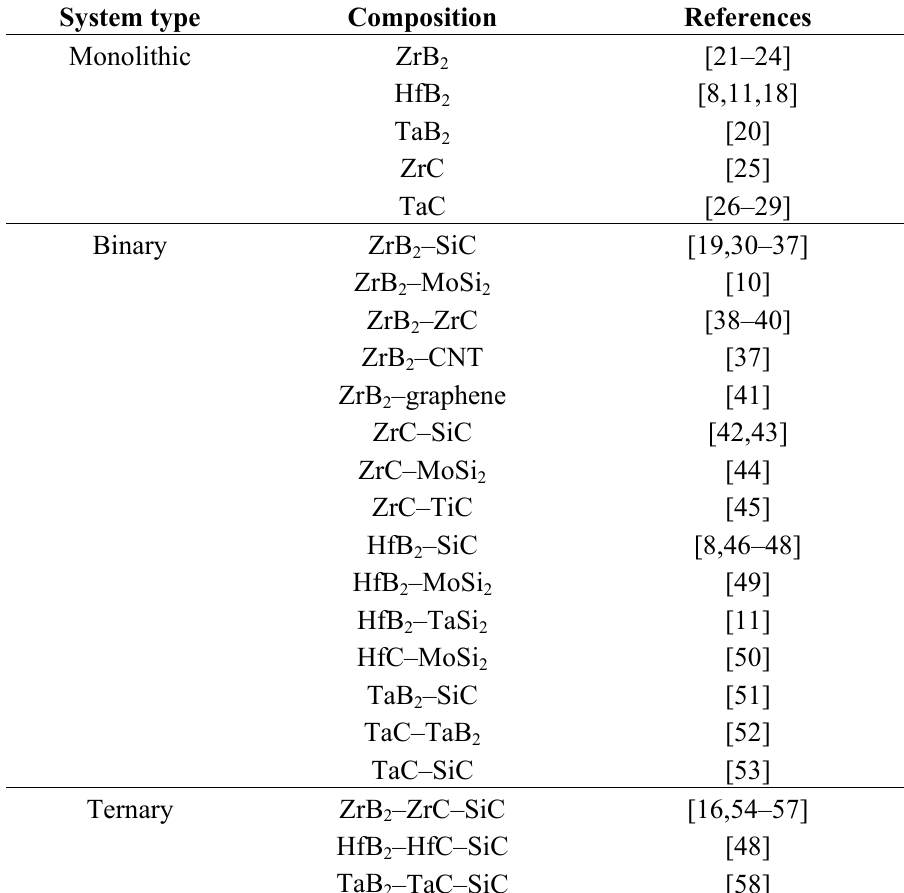
Table 1. Monolithic and composite bulk ultra high temperature ceramics (UHTC) systems investigated by Spark Plasma Sintering